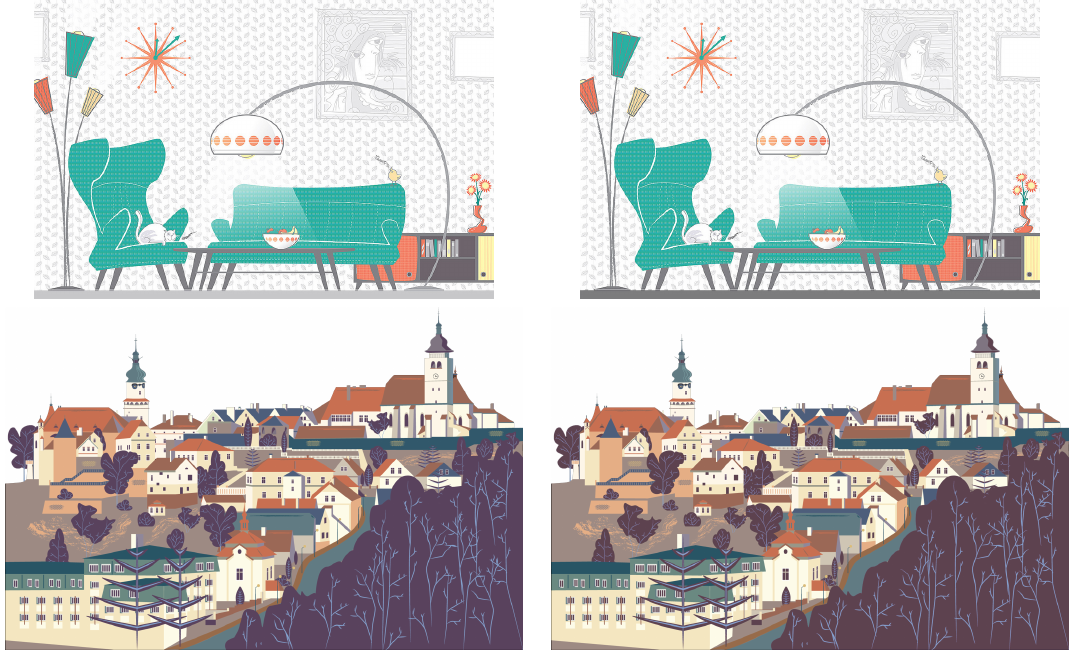
Figure 5. Examples of low salience imbalance but high change magnitude (top) and vice versa (bottom). Note that the top pair has a very large difference, but, at the bottom edge of the scene, which does not immediately attract attention. On the other pair, the difference in color is subtle, but it is over a very large region, which is why it gets picked up by the bottom-up salience